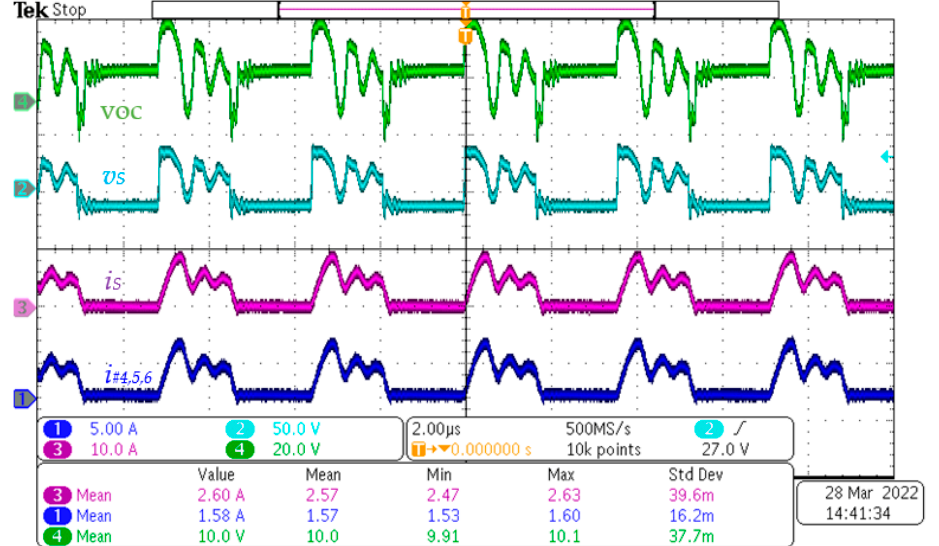
Figure 13. Waveforms of battery charging with 12 V/2.6 A on the secondary side using the flyback converter.